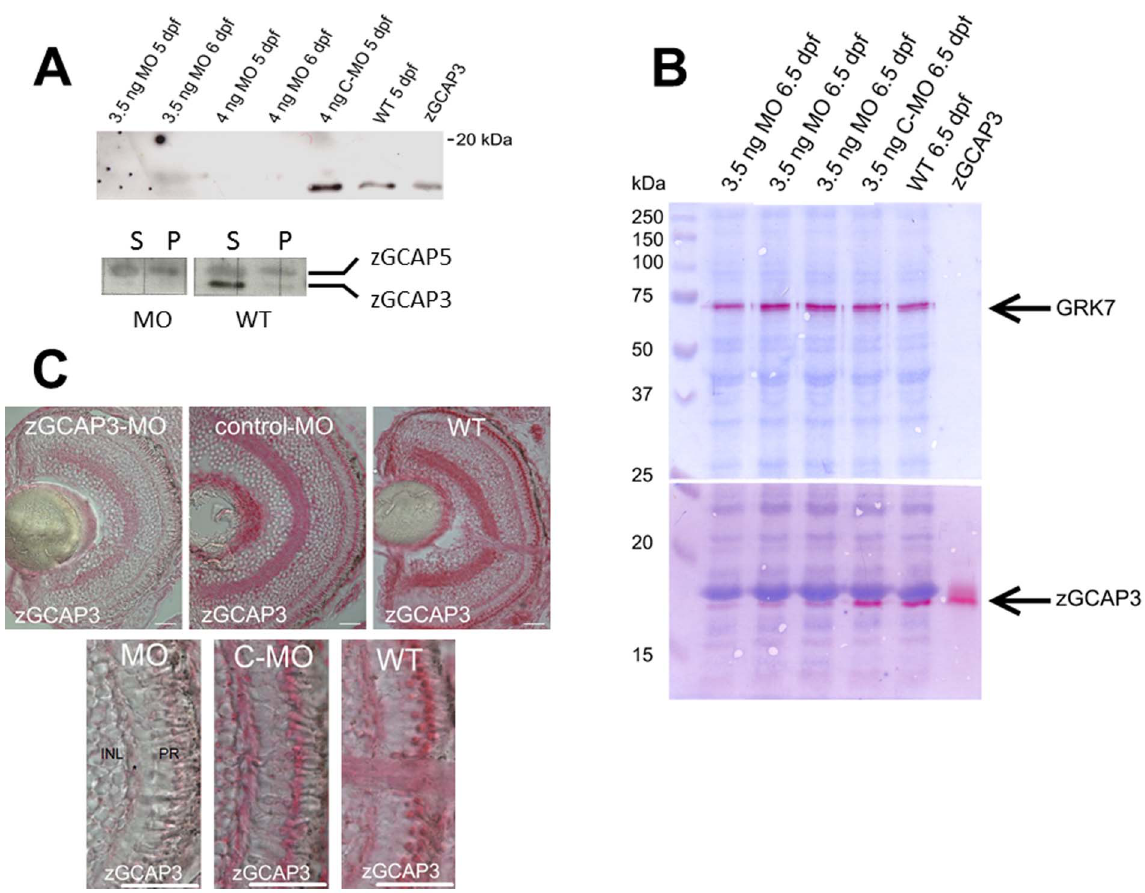
Figure 6. Morpholino knockdown of zGCAP3 in zebrafish larvae. (A) upper panel: Immunoblotting of homogenized eyes obtained from larvae at 5 and 6 dpf that had been injected with the indicated amount of MOs. Recombinant nonmyristoylated zGCAP3 (1 ng) was loaded on the very right lane. Purified polyclonal anti-zGCAP3 was used at 1:250, second antibody was a peroxidase-coupled goat anti-rabbit IgG at a dilution of 1:5000. Lower panel: Immunoblotting as above of MO treated and WT larvae (5 dpf, 10 eyes each). Supernatant (S) and pellet (P) fraction of larval eye homogenates were probed by polyclonal anti-zGCAP3 and anti-zGCAP5 antibodies (dilution of 1:200 and 1:250, respectively). Second antibody was a peroxidase-coupled goat anti-rabbit IgG at a dilution of 1:2500. (B) Analysis of larval eyes at 6.5 dpf by immunoblotting. The same larvae (three lanes that were identically labeled ‘‘MO 6.5 dpf’’) had been investigated in the optomotor response measurements at 6 dpf. Proteins were first fixed in the polyacrylamide gel according to ref. [34] before transfer to the blot membrane. Reactive antibody binding was visualized by using Fast Red. The anti- GRK7 antibody was used at a dilution of 1:1000. Use of other antibodies as in (A). (C) Immunohistochemistry of larval eyes at 5 dpf as indicated. Cryosection of 10 m m were labeled with the purified polyclonal anti-zGCAP3 antibody at a dilution of 1:2000, secondary antibody was a goat anti- rabbit conjugated to alkaline phosphatase, dilution at 1:200. Scale bars: 20 m m. The lower part of the figure is a magnified part of the upper figures showing the photoreceptor cell layer. difference, whether the grating consisted of alternating black and white or black and green/red stripes ( P $ 0.05).